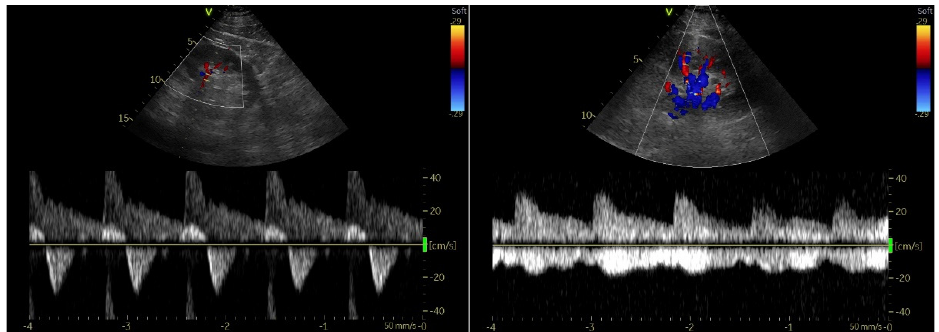
Figure 12. Intrarenal vein Doppler (above baseline) in a patient with acutely decompensated heart failure before (left) and after (right) decongestive therapy. The flow pattern appears monophasic/di- astolic (L), becoming continuous as congestion reduces (R).